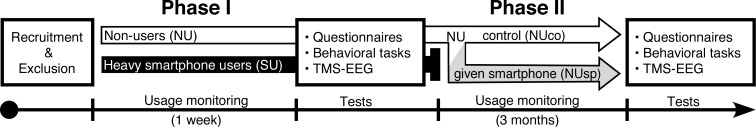
Timeline of recruitment, allocation and procedures.35 participants (19 females; mean age 25±3.8 years [range: 21–32 years]) lacking any previous experience with or possession of a smartphone, but in possession of a standard mobile phone, were allocated to the nonusers (NU) group. The second, heavy smartphone users (SU) group, was recruited using the smartphone addiction scale (SAS) and the mobile phone involvement questionnaire (MPIQ) administered online to 2711 participants. Participants who scored more than 2 standard deviations above the mean in both questionnaires were recruited via telephone interview to form the SU group. This group consisted of 16 participants (9 females; mean age 24±2.5 years [range: 21–27 years]). A subset (n = 28 total; n = 25 with TMS) of the NU participants consented to a second phase. In the second phase 11 of the NU participants (7 females; mean age 24.7±2 years [range: 21–29]) were randomly selected to receive smartphone devices for a 3 months period (NUsp) while 14 others of the NU participants (8 females; mean age 24.9±2.2 years [range 22–28]) served as matched controls (NUco), the remainder of the NU sample and the SU group were released from the study immediately after the first phase. See S1 and S2 Tables for full demographics of all groups.